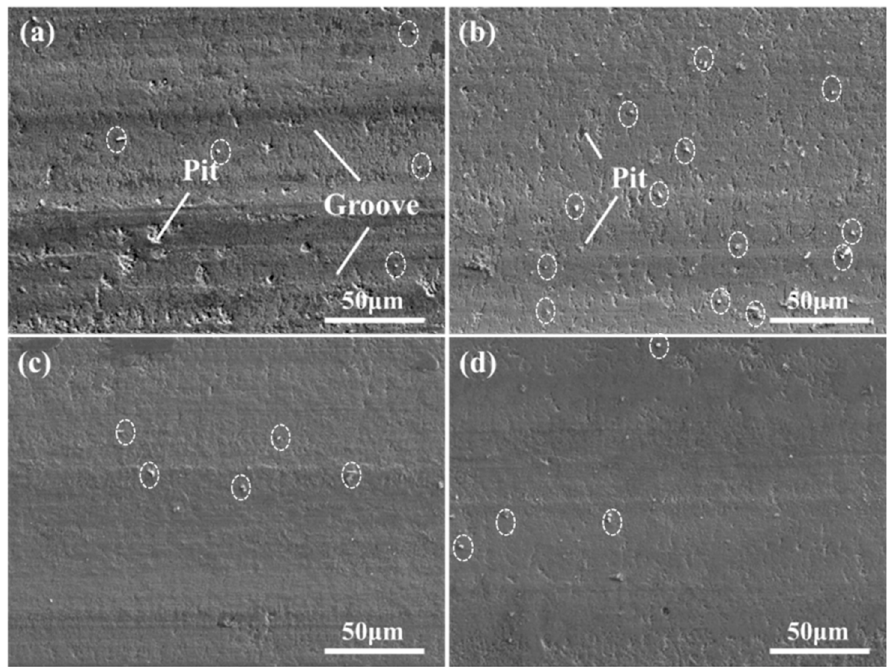
Figure 10. Wear morphology under 2 N load with pits and Grooves. ( a ) 0#, ( b ) 1#, ( c ) 2#, ( d ) 3#.